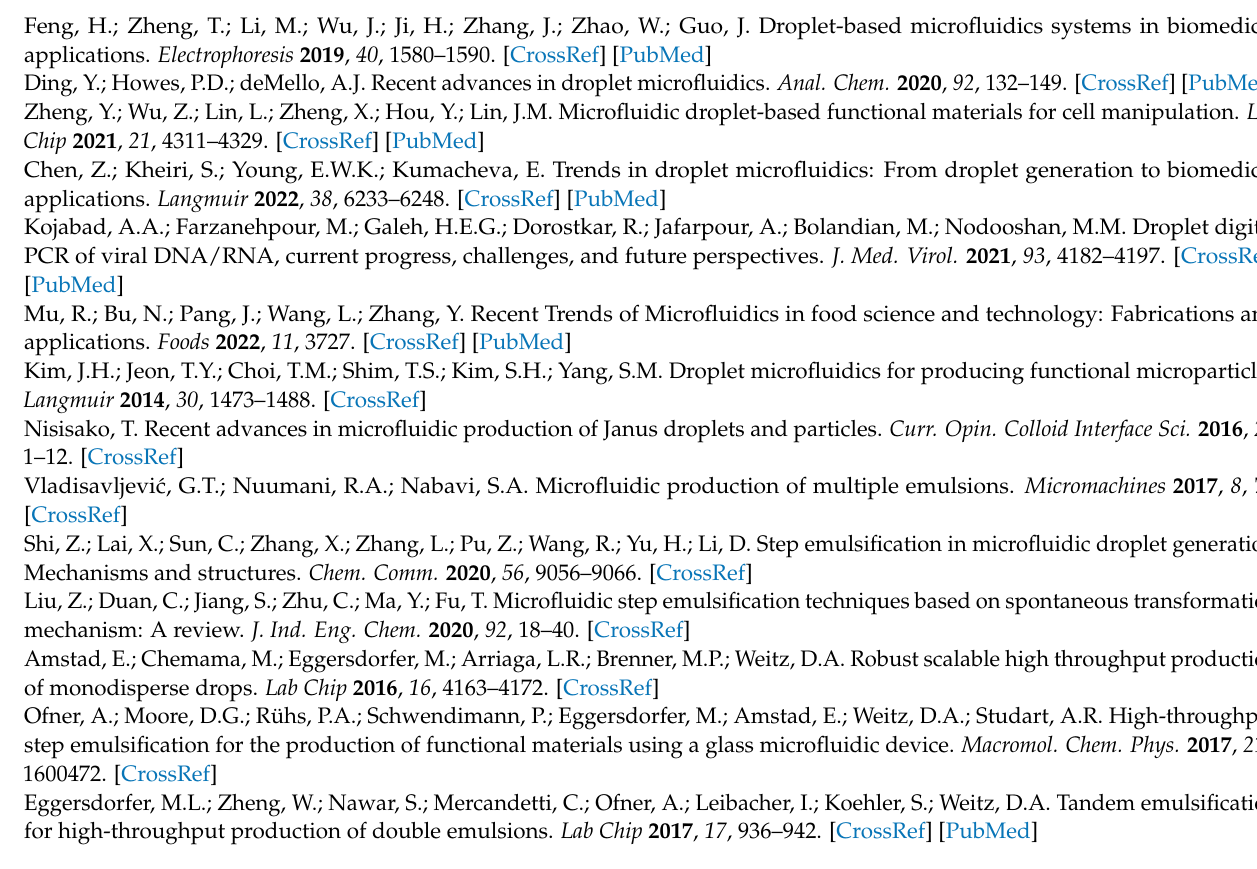
DLD pillars, Figure S2: Scanning electron microscopy images of the SU-8 mold for PDMS casting, Figure S3: Contact angle measurements, Figure S4: Overall experimental setup, Figure S5: Droplet accumulation and coalescence in the devices, Figure S6: Effect of the flow conditions on the formation of droplets and their coalescence, Figure S7: Main droplet migration through the DLD pillars at Q d = 0.2 mL/h and Q c = 10.0 mL/h, Figure S8: Satellite droplet migration through the DLD pillars at Q d = 0.2 mL/h and Q c = 10.0 mL/h, Figure S9: Main droplet migration in the no-pillar device at Q d = 0.2 mL/h and Q c = 10.0 mL/h, Video S1: Step emulsification at a low magnification, Video S2: Step emulsification at a high magnification, Video S3: Main droplet migration through the DLD pillars, Video S4: Satellite droplet migration through the DLD